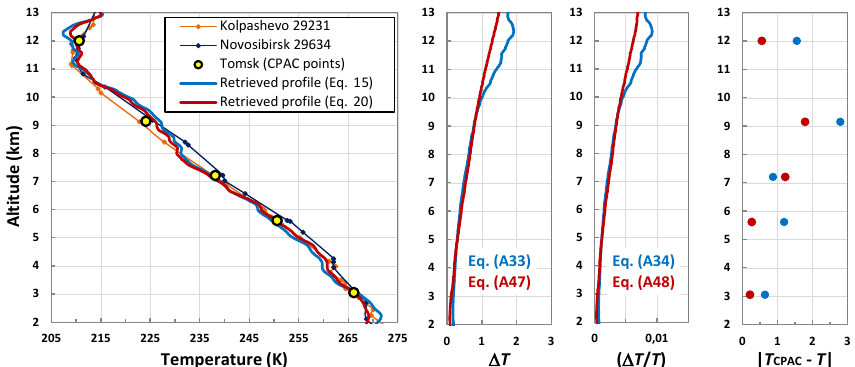
Figure 14. (2 October 2014) Temperature profiles retrieved using Eqs. (15) and (20).